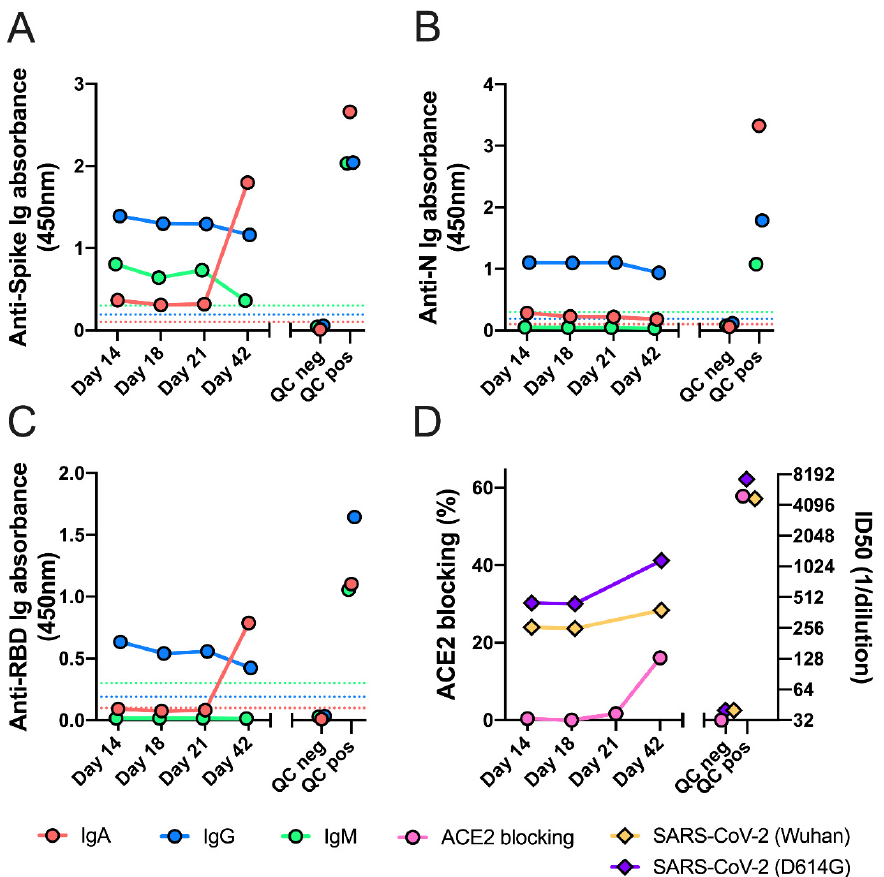
Figure 3. Anti-SARS-CoV-2 serologies and neutralizing antibodies. Plasma samples were analyzed by ELISA at a 1:100 dilution for the presence of IgG, IgA and IgM antibodies binding to the SARS-CoV-2 spike (Panel ( A )), nucleocapsid (Panel ( B )), and RBD (Panel ( C )) antigens. Panel ( D ) shows the results of testing for antibodies that block the binding of ACE2 to RBD, carried out with a 1:10 dilution of plasma (left y -axis). Pseudovirus neutralizing antibodies were detected with in vitro cell culture assay with D614 (Wuhan-Hu-1) pseudovirus and D614G pseudovirus (right y -axis). For all panels, time on the x -axis indicates days after symptom onset during SARS-CoV-2 reinfection. Plasma pools from SARS-CoV-2 pre-pandemic healthy blood donors and from primary infection COVID-19 patients were used as negative and positive quality control (QC), respectively. The dotted lines are the cutoffs value for a positive result for each assay, determined as described in the Supplemental Materials. All samples were tested in duplicate wells; mean OD values are shown. Results are shown from one of two replicate experiments carried out on different